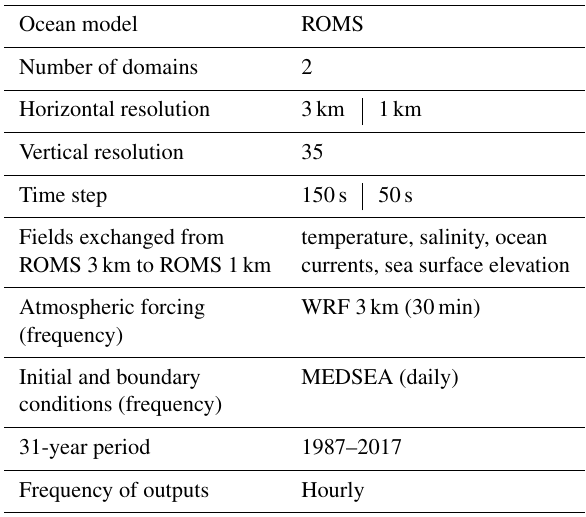
Table 1. Summary of the AdriSC climate component ocean model main features for the evaluation